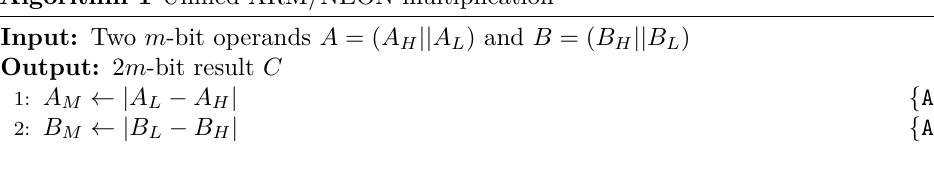
Algorithm 1 Unified ARM/NEON